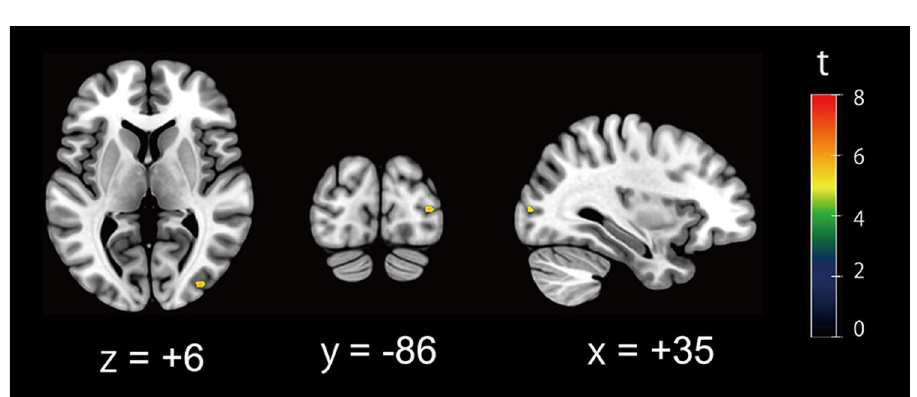
Figure 3. Brain region showing the significant correlation between gray matter (GM) volume and SVBA performance. The significant clusters are superimposed on the axial (left), coronal (center), and sagittal slices (right) of the standardized anatomical image. A color bar represents the t value. The GM volume in the right middle occipital gyrus (peak MNI coordinate x = 35, y = − 86, z = 6; t = 5.85; cluster size = 31 voxels) was significantly positively correlated with the TE values in the SVBA task ( p < 0.05 FWE-corrected at the voxel and cluster levels).